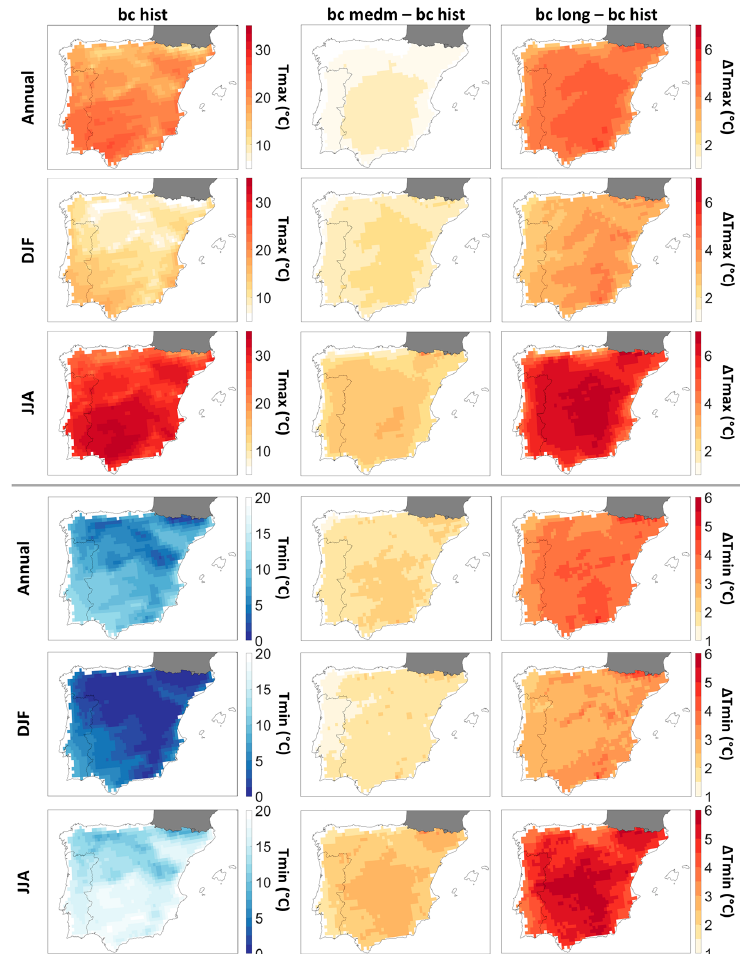
Figure 6. Mean daily maximum and minimum temperature (Tmax and Tmin, °C) for the historical period (bc hist, first column). Differences between the medium- and long-term future and the historical period [bc medm–bc hist (second column) and bc long–bc hist (third column), respectively]. Statistically significant differences (Student’s t -test) at 5% significance level were verified in all the grid points. Atmosphere 2019 , 10 , x FOR PEER REVIEW